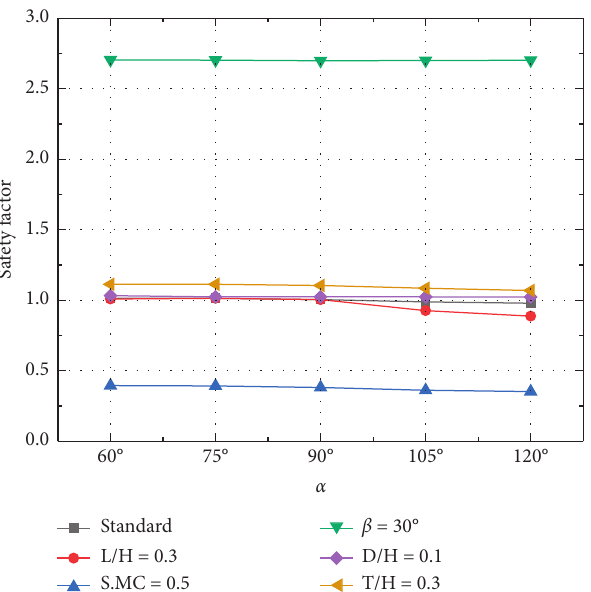
Figure 17: The influence of the crack angle on slope